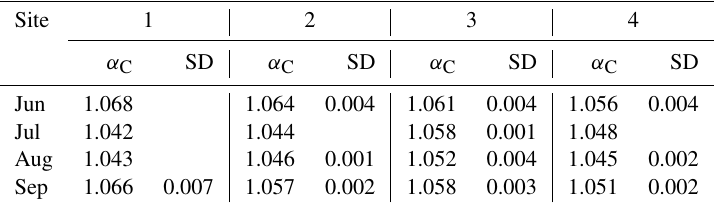
Table 2. The α C values and SD obtained from silicone samplers in 35cm of depth at sites 1–4 from June to September. The α C values between 1.04 and 1.055 indicate the prevalence of the acetoclastic CH 4 production pathway, and α C values higher than 1.065 indicate the hydrogenotrophic